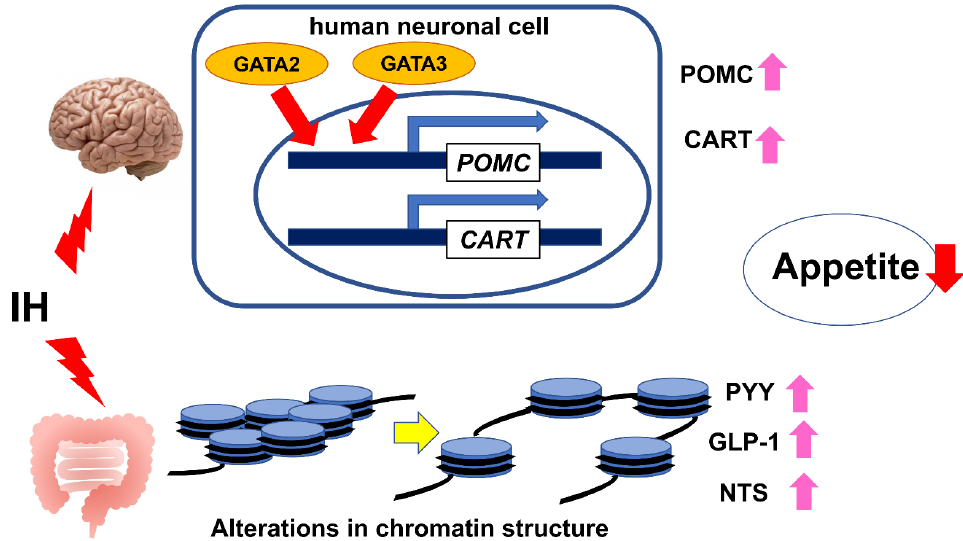
Figure 2. The relationship between IH and the gut–brain axis in appetite control. IH observed in SAS patients can have anorexigenic effects on the gut–brain axis by the up-regulation of POMC and CART mRNA expression via GATA transcription factors (GATA2 and GATA3) in neuronal cells [104] and by the up-regulation of PYY , GLP-1 , and NTS mRNAs through an alteration in chromatin structures of the PYY , GLP-1 , and NTS genes in enteroendocrine cells [106].